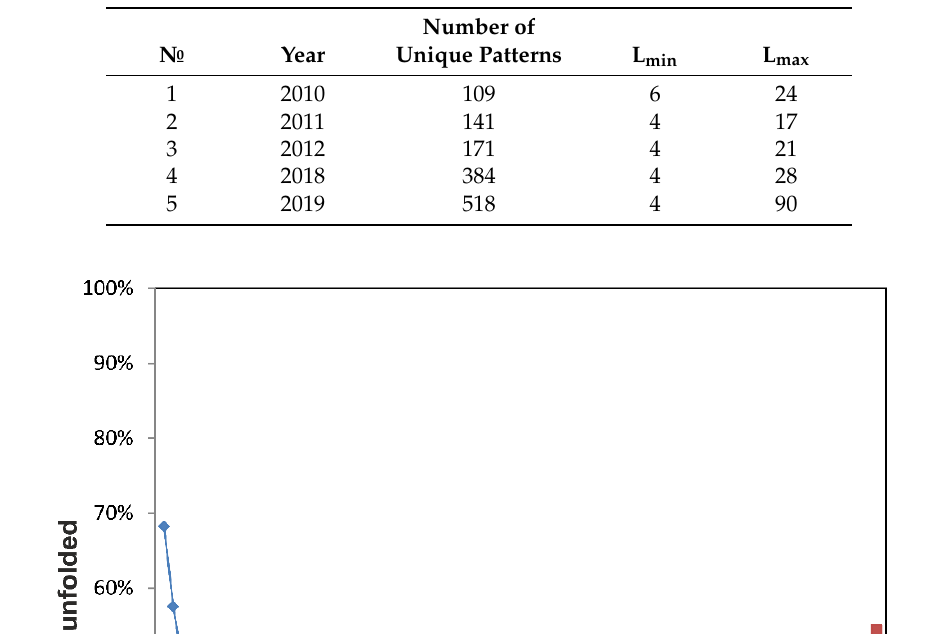
Table 3. Comparison of data for the di ff erent versions of libraries of disordered patterns (L min is the minimum length of pattern and L max is the maximum length of pattern).